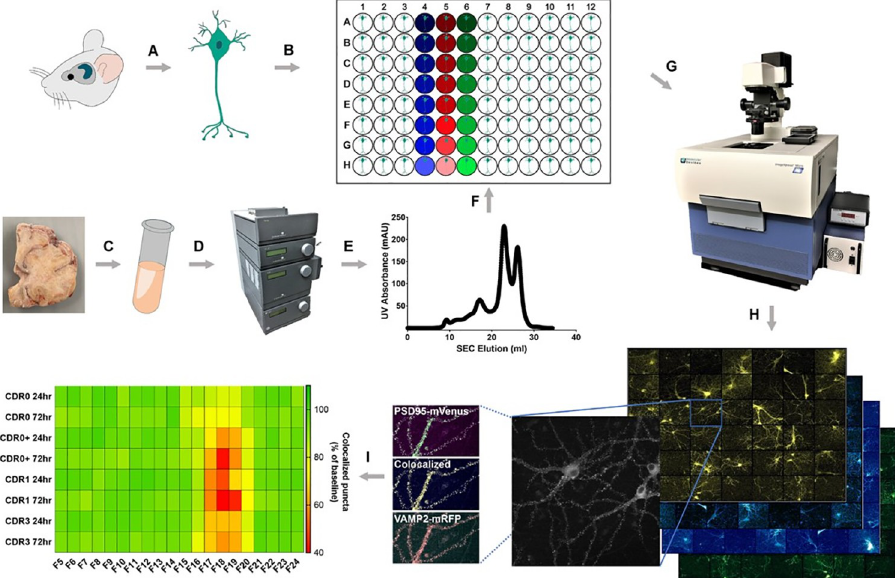
Fig 1. Schematic of the assessment of synaptic changes using the high-content imaging system. (A, B) Hippocampal neurons from genetically modified mice with fluorescent synapses were isolated and cultured in treated 96-well microplates for more than 20 days in vitro (DIV); (C-F) Human frontal cortex homogenates from control and AD samples were separated by size exclusion chromatography (SEC) and added to individual wells of 96 well plates; (G) Synapses were imaged before and after the addition of fractionated human brain samples using the ImageXpress high-content screening system equipped with environmental control unit for live cell imaging; (H) Pre-synaptic VAMP2-mRFP puncta, post-synaptic PSD95-mVenus puncta, and colocalized puncta were analyzed; (I) Heat map analysis showed synaptotoxic activities in SEC fractions from control and AD human samples at 24 and 72 hours; significant loss of colocalized synaptic puncta was identified in neurons exposed to low molecular weight (F17-20) fractions. https://doi.org/10.1371/journal.pone.0259335.g001 PLOS ONE | https://doi.org/10.1371/journal.pone.0259335 November8,